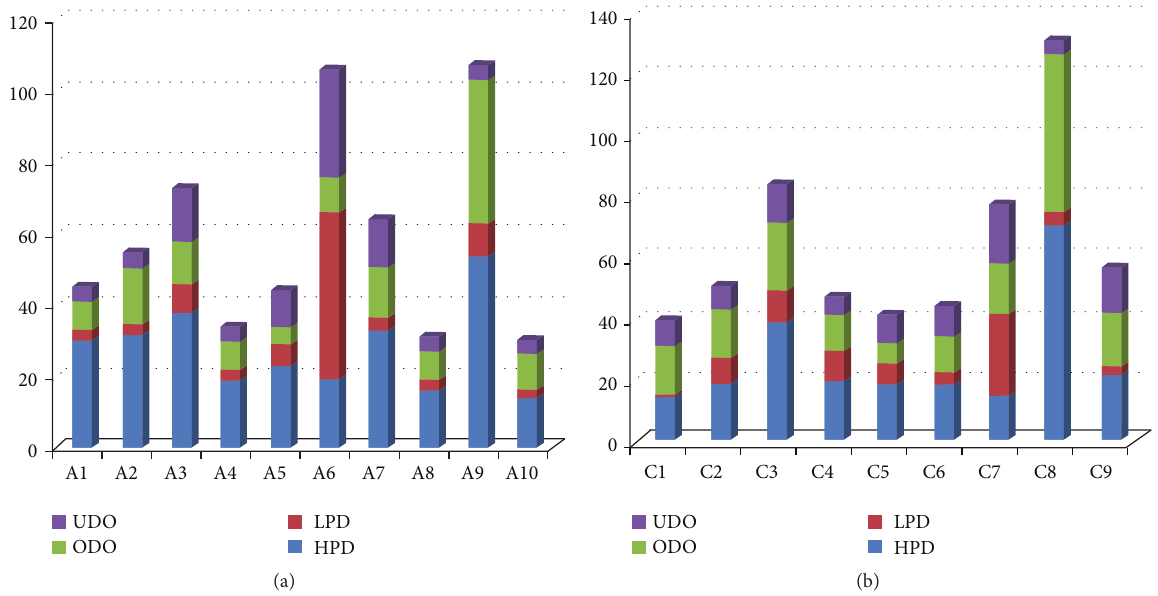
Figure 4: Chromosomal distribution of nonadditive differentially expressed genes with high-parent dominance (HPD), low-parent dominance (LPD), overdominance (ODO), and underdominance (UDO) on the A genome (a) and C genome (b).